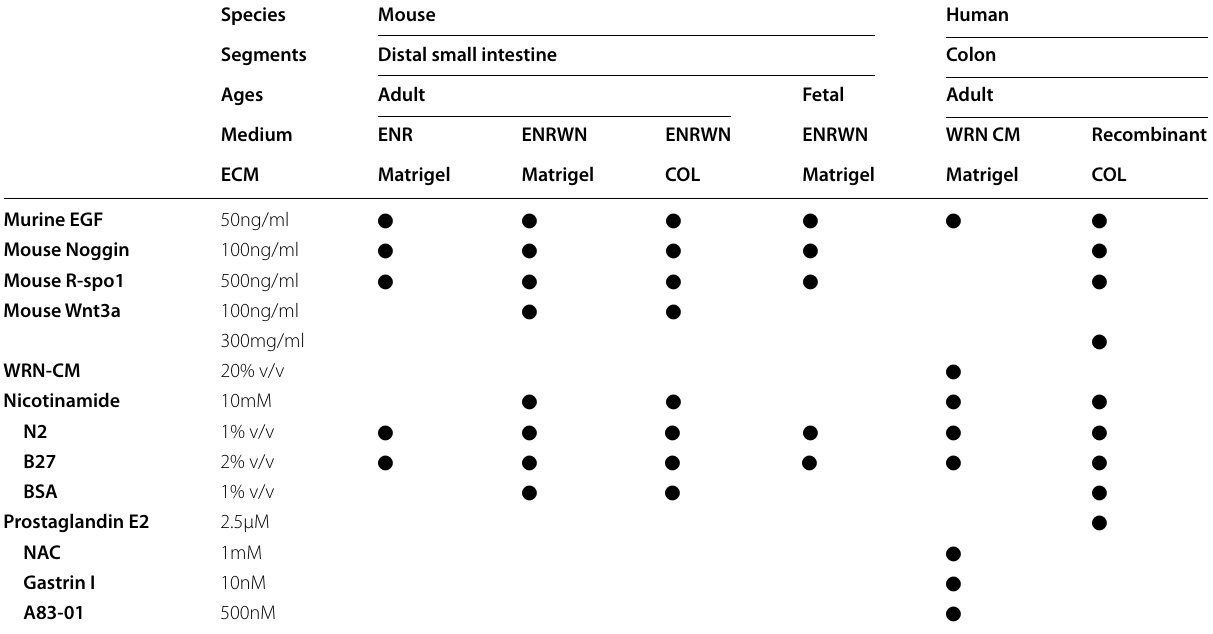
Table 1 Culture conditions: culture conditions for mouse and human organoids are summarized in